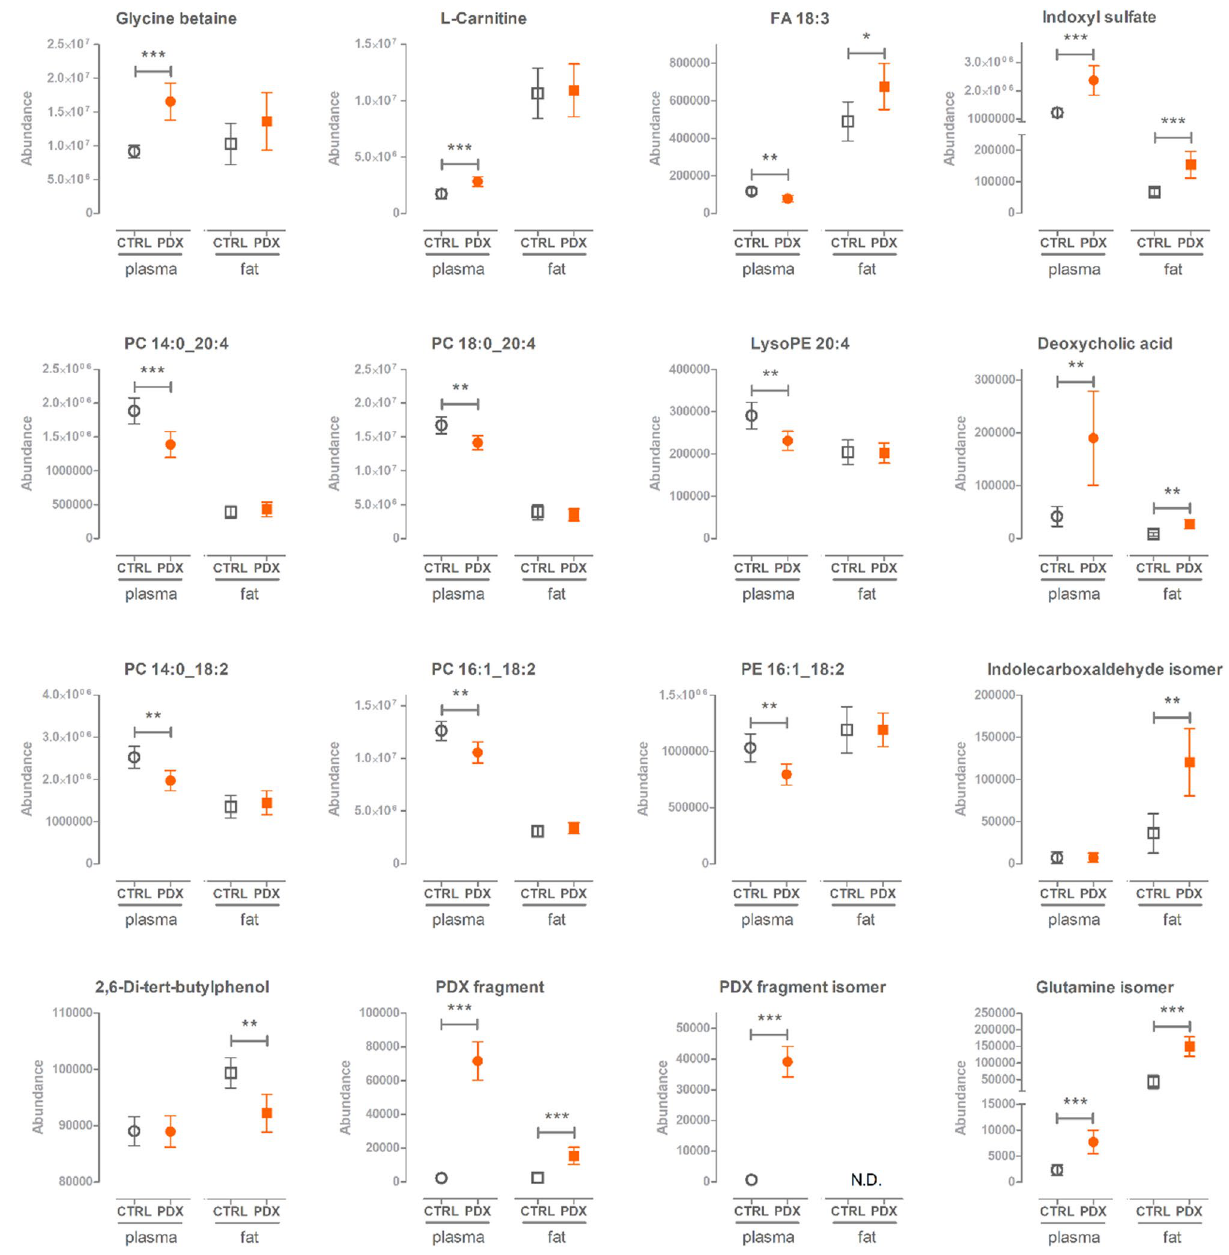
t-test was used to calculate p values. Legend: *** p < 0.001, ** p < 0.01, * p < 0.05. FA, fatty acid; N.D., not detected; PC, phosphatidylcholine; PDX, polydextrose; PE,